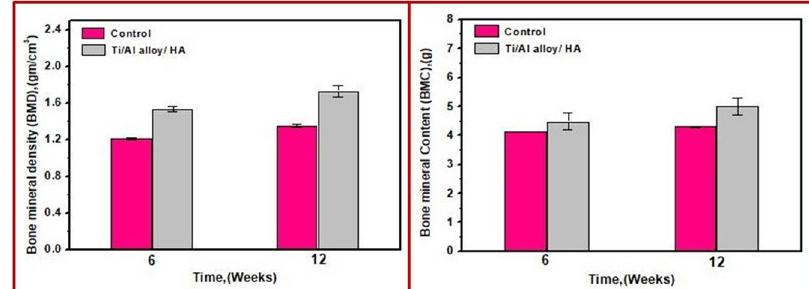
Fig. 11 Mean values for bone mineral density (BMD) (g/cm 2 ) and bone mineral content (BMC) (g) for the control groups and the treated